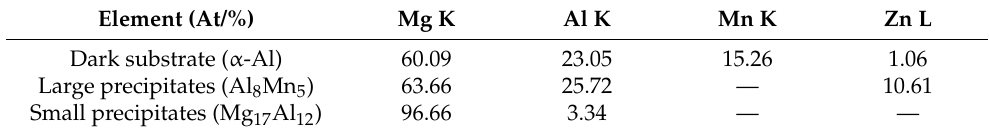
Small precipitates (Mg 17 Al 12